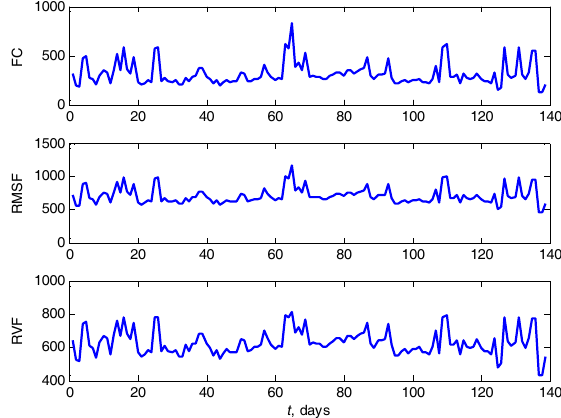
Figure 11. Frequency-domain features: FC, RMSF and RVF calculated from the vibration slew bearing signal.